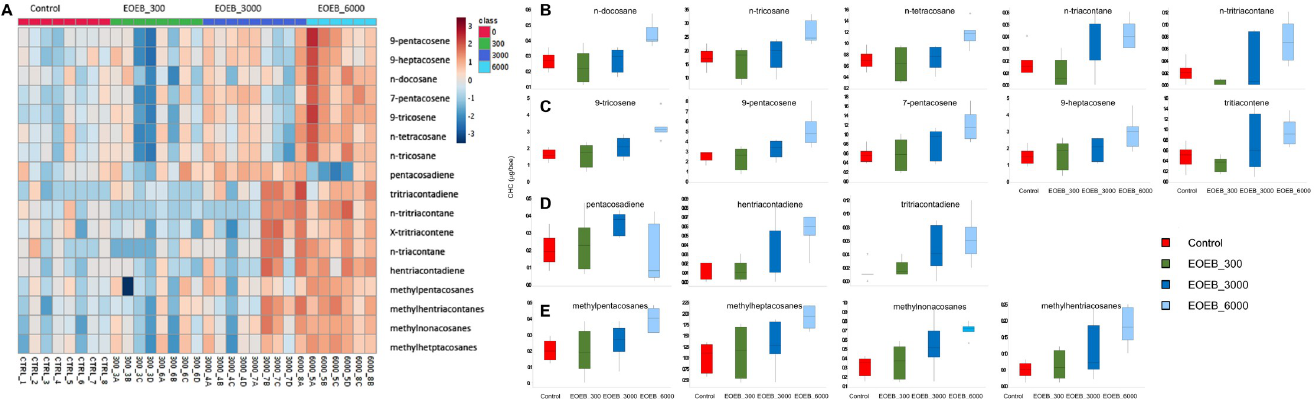
Fig 4. Agglomerative, hierarchical cluster analysis on the individual CHC in honeybees fed on EO-enriched diets at different doses: Heatmap ( A , distance measured using Euclidean, and clustering algorithm using ward.D in Metaboanalyst [44]). The colored boxes on the right indicate the relative concentrations of the corresponding metabolite in each group under study. Boxplots of the selected CHC that accounted for significant differences (identified from variable importance in projection (VIP) in a PLS-DA: B , linear alkanes; C , Alkenes, D , Alkadienes and E , branched alkanes. Boxes represent 95%-intervals around the media (horizontal bar within a box) calculated as 1.58 � IQRT